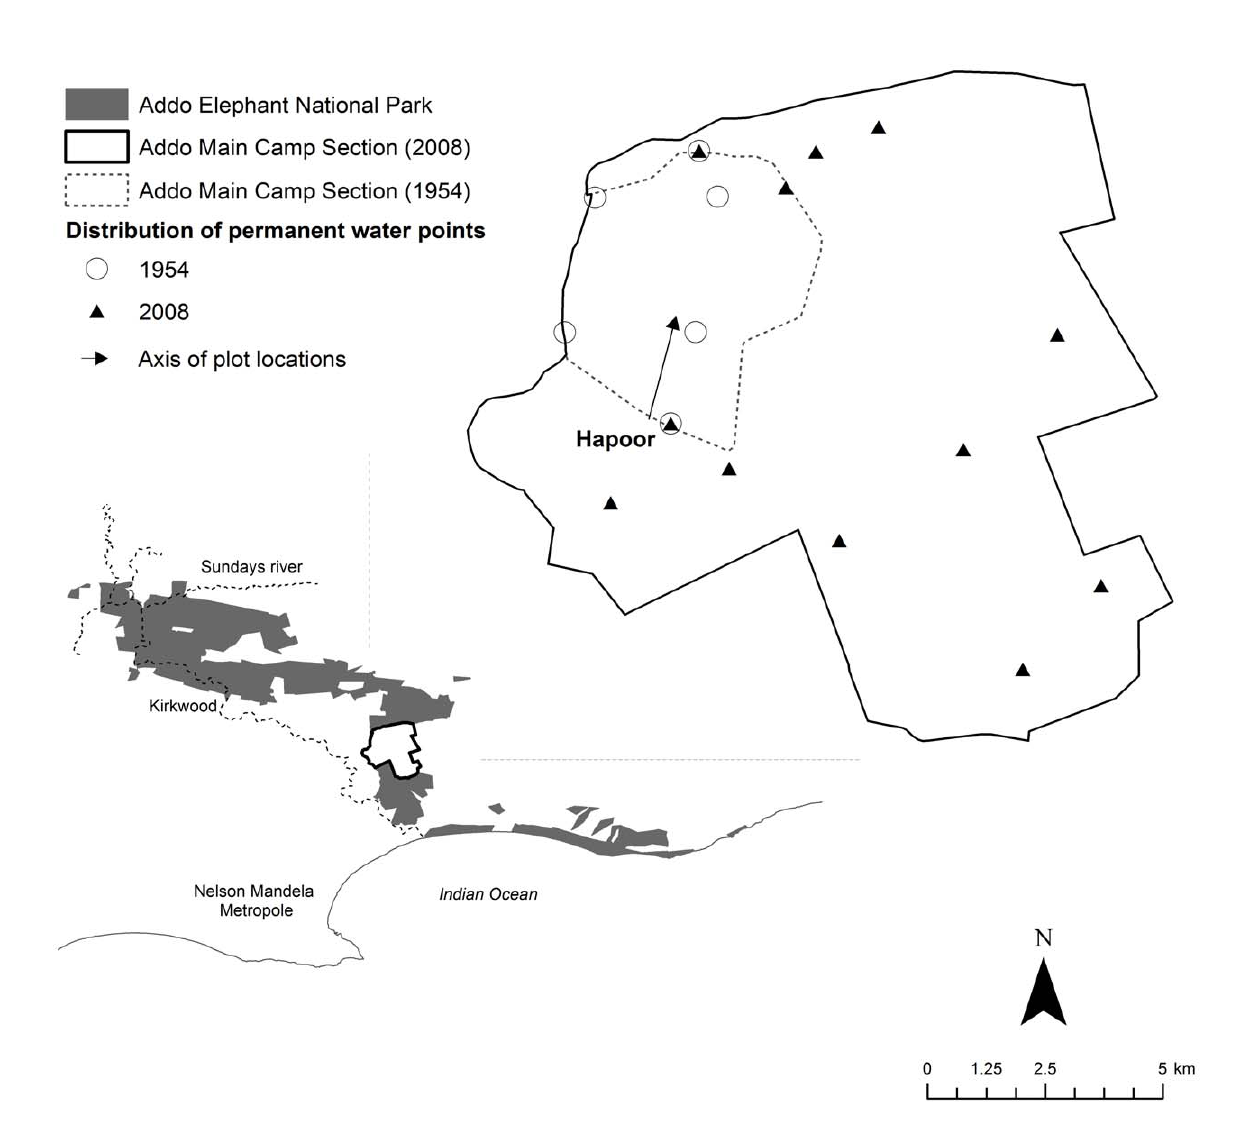
Figure 1. Location of water points in the Addo Main Camp section (study area), Addo Elephant National Park. Experimental plots were placed at increasing distances from Hapoor water point in the area originally fenced in 1954. The incremental expansion of AMC caused a substantial increase in the number of permanent artificial water points (from 6 in 1954 to a total of 12 in 2008); only two of these (shown by overlapping symbols) maintained water availability for elephant since the initial